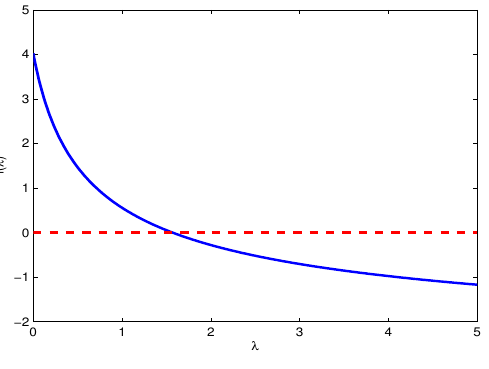
Figure 1. f ( λ ) for different λ ∈ [ 0,5 ]